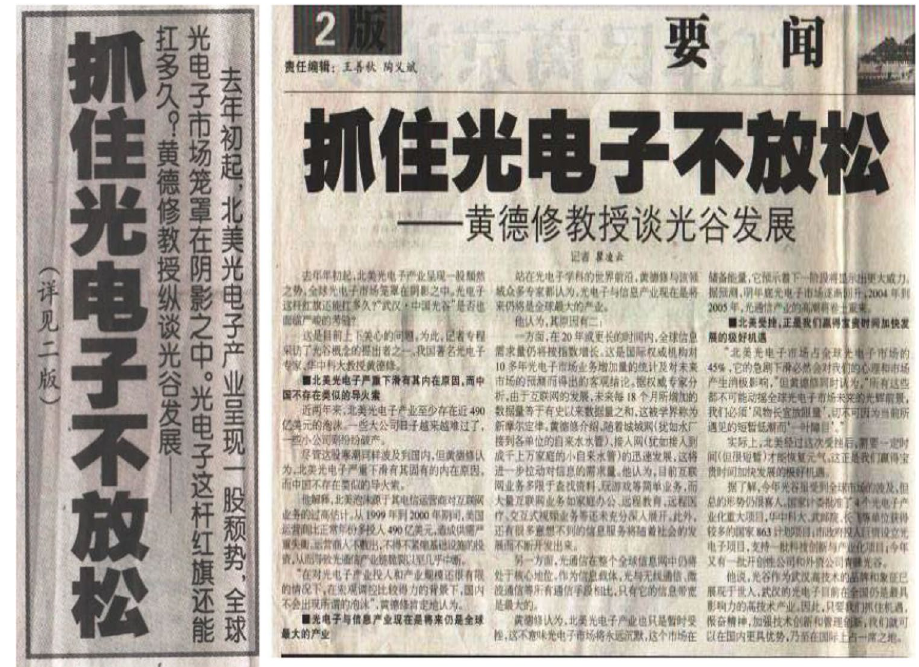
Fig. 6 Huang’s report, entitled as “ Grasp optoelectronics and hold on to it” was published on the first page of Changjiang Daily on October 23,